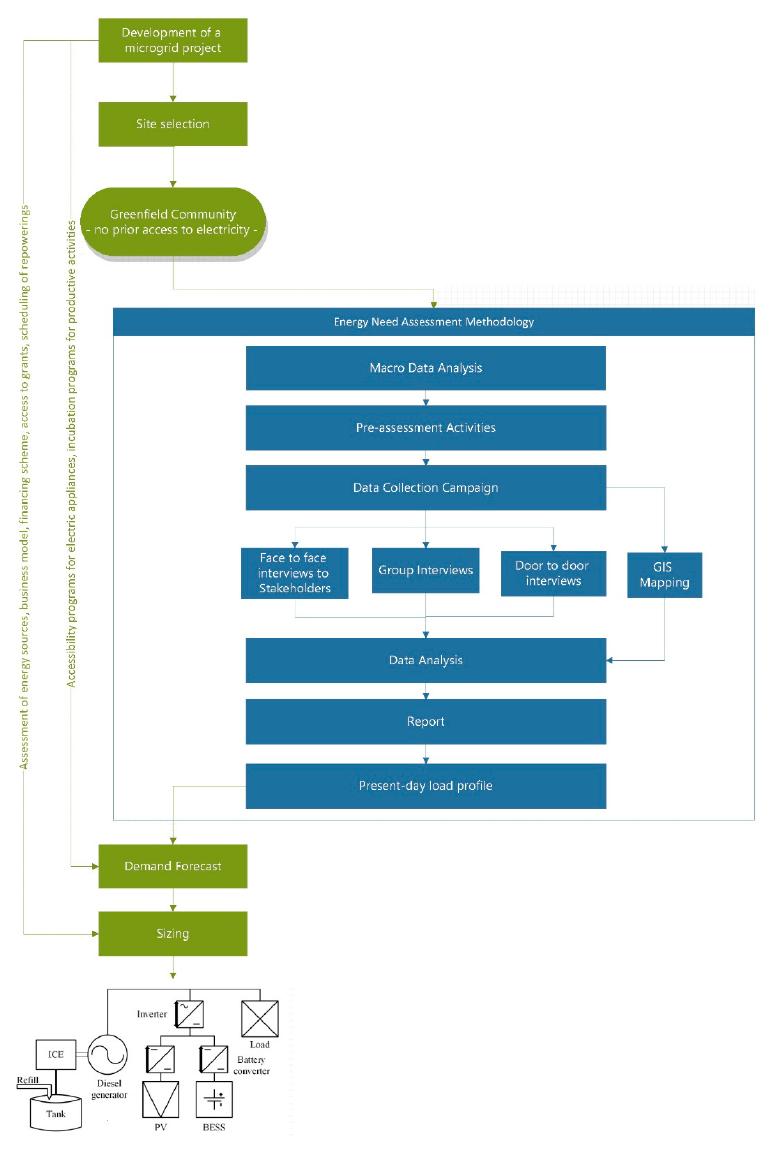
Figure 1. Development process flowchart for greenfield mini-grid projects.